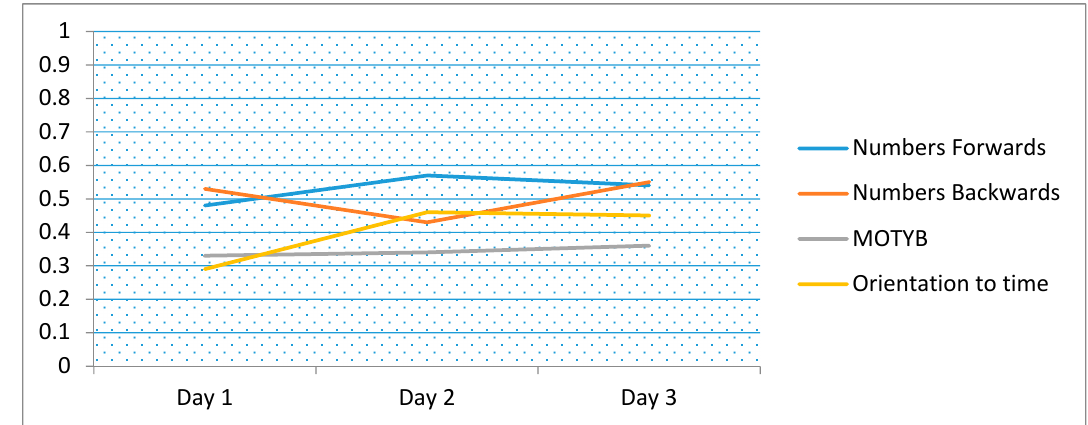
Figure 2. Correlation coefficients for logical memory compared to short tests of attention including months of the year backwards (MOTYB) and orientation (time of the day), over time (days 1 to 3). (Note: n = 79, excluding those <50 years).